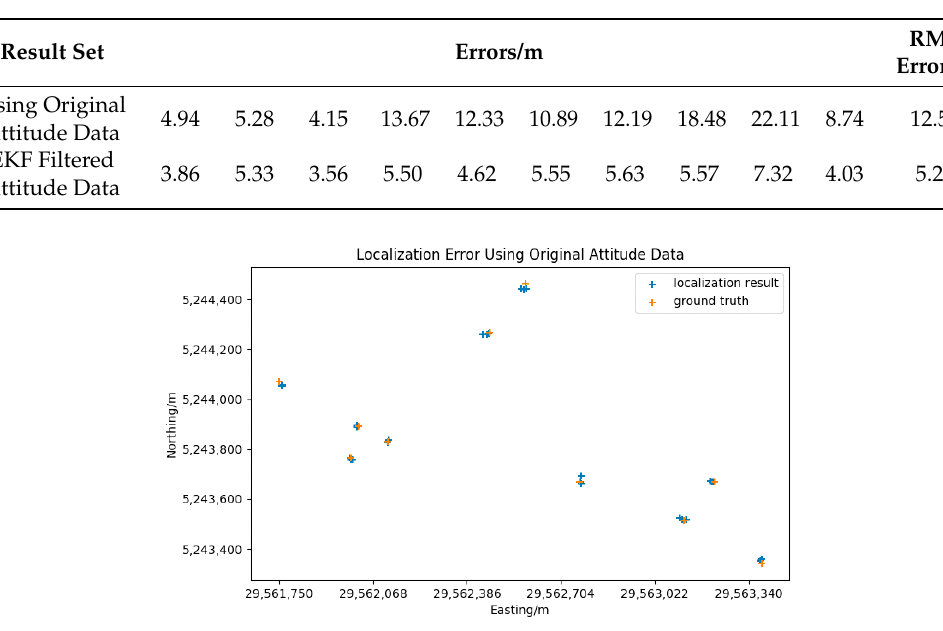
Figure 12. The process of target localization. The red crosses represent the target points. ( Left ) Target point 1, 2 and 3. ( Right ) Target point 8, 9 and 10.